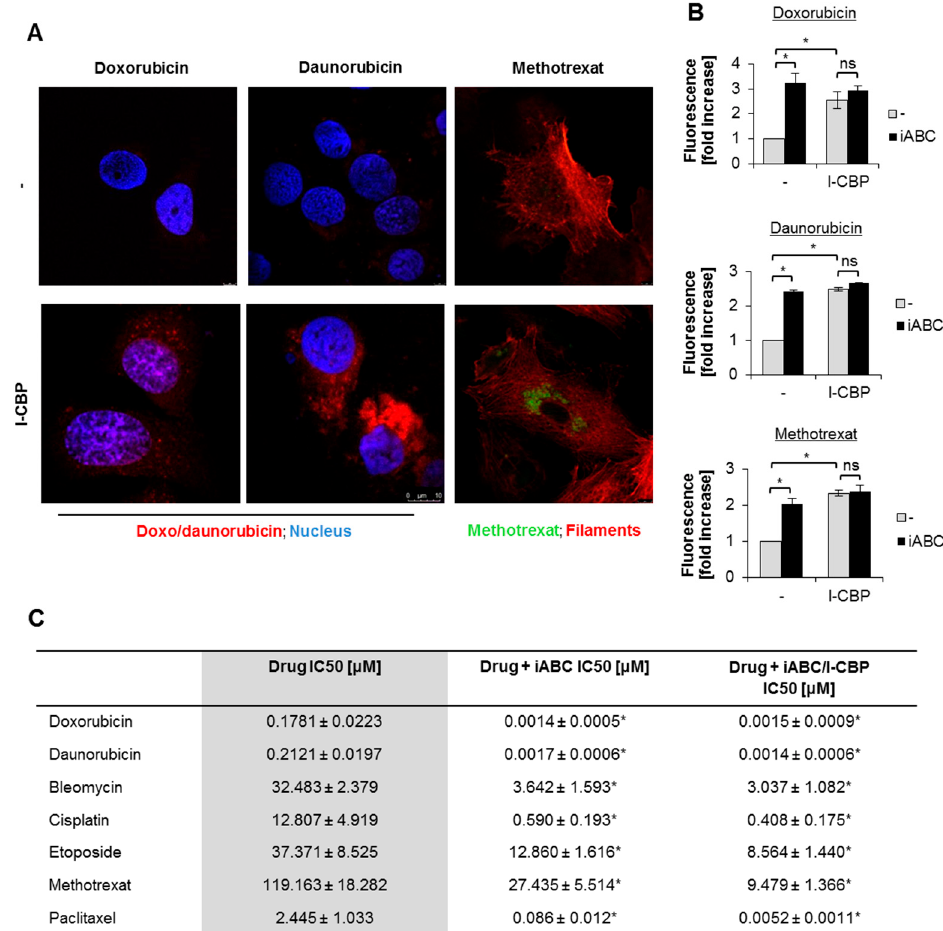
Figure 2. I-CBP increased the accumulation of some anticancer drugs and phenocopied the effect of ABC inhibitor in MDA-MB-231 breast cancer cells. ( A ) A confocal microscope was used to track doxorubicin, daunorubicin, and methotrexate autofluorescence in MDA-MB-231. The nuclei in anthracycline (red)-treated cells were additionally stained with DAPI (blue), whereas actin filaments were stained with phalloidin-TexasRed (red) conjugate in cells incubated with methotrexate (green). To cells, we added anthracyclines (0.5 µM) and methotrexate (5 µM) for 24 h. ( B ) The autofluorescence of cells incubated with the drugs for 4 h was measured using a fluorescence reader. iABC (probenecid; 200 µM) was added 2 h prior to cell treatment with anticancer drugs. ( C ) IC50 for anticancer drug toxicity was estimated using the resazurin viability assay. iABC (probenecid; 200 µM) was added 2 h, whereas I-CBP112 (10 µM) was added 72 h, prior to cell treatment with anticancer drugs. Bars in the figures represent the mean ± standard error of the mean (SEM). ( B ) Variability among groups was tested with two-way ANOVA and the Bonferroni test. Statistically significant effects of I-CBP112 are marked with * when p < 0.05. ( C ) Two-way ANOVA and the Bonferroni test were used to test variance among the IC50 values of control, I-CBP112-, iABC-, and iABC/I-CBP112-pretreated cells. The effect of I-CBP112 is marked with * when p < 0.05.